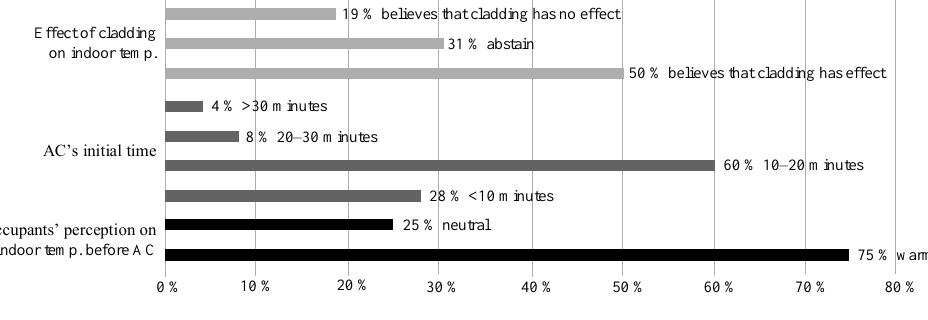
Effect of cladding on indoor temp.